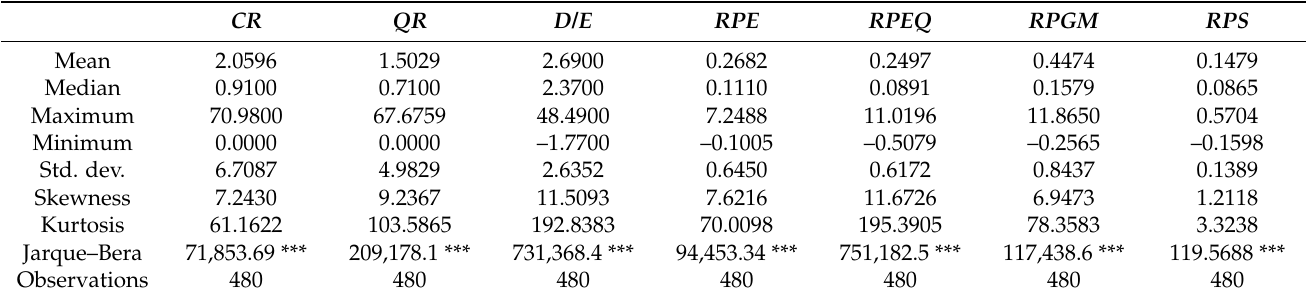
Table 1. Descriptive statistics for electricity companies.